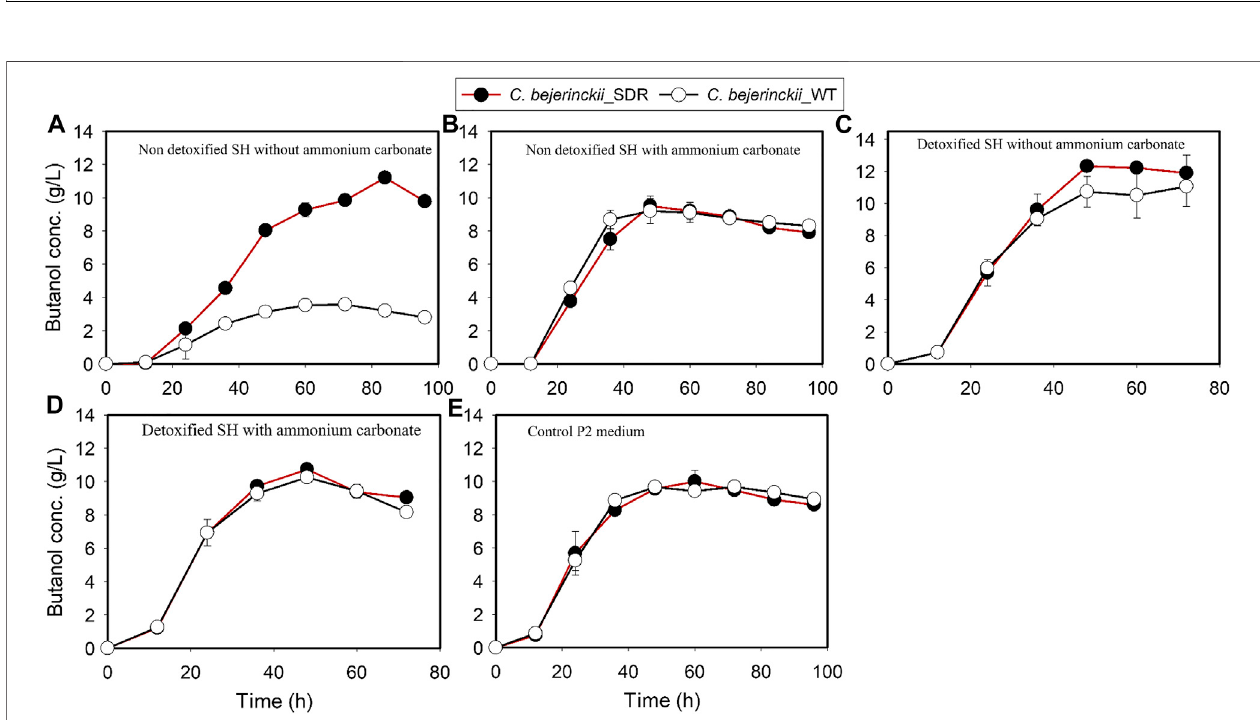
FIGURE 7 | Butanol concentration pro fi les in cultures of C. beijerinckii _SDR or C. beijerinckii _wildtype grown in SH and P2 medium control. (A) Non-detoxi fi ed SH without ammonium carbonate. (B) Non-detoxi fi ed SH with ammonium carbonate. (C) Detoxi fi ed SH without ammonium carbonate. (D) Detoxi fi ed SH with ammonium carbonate. (E) Control P2